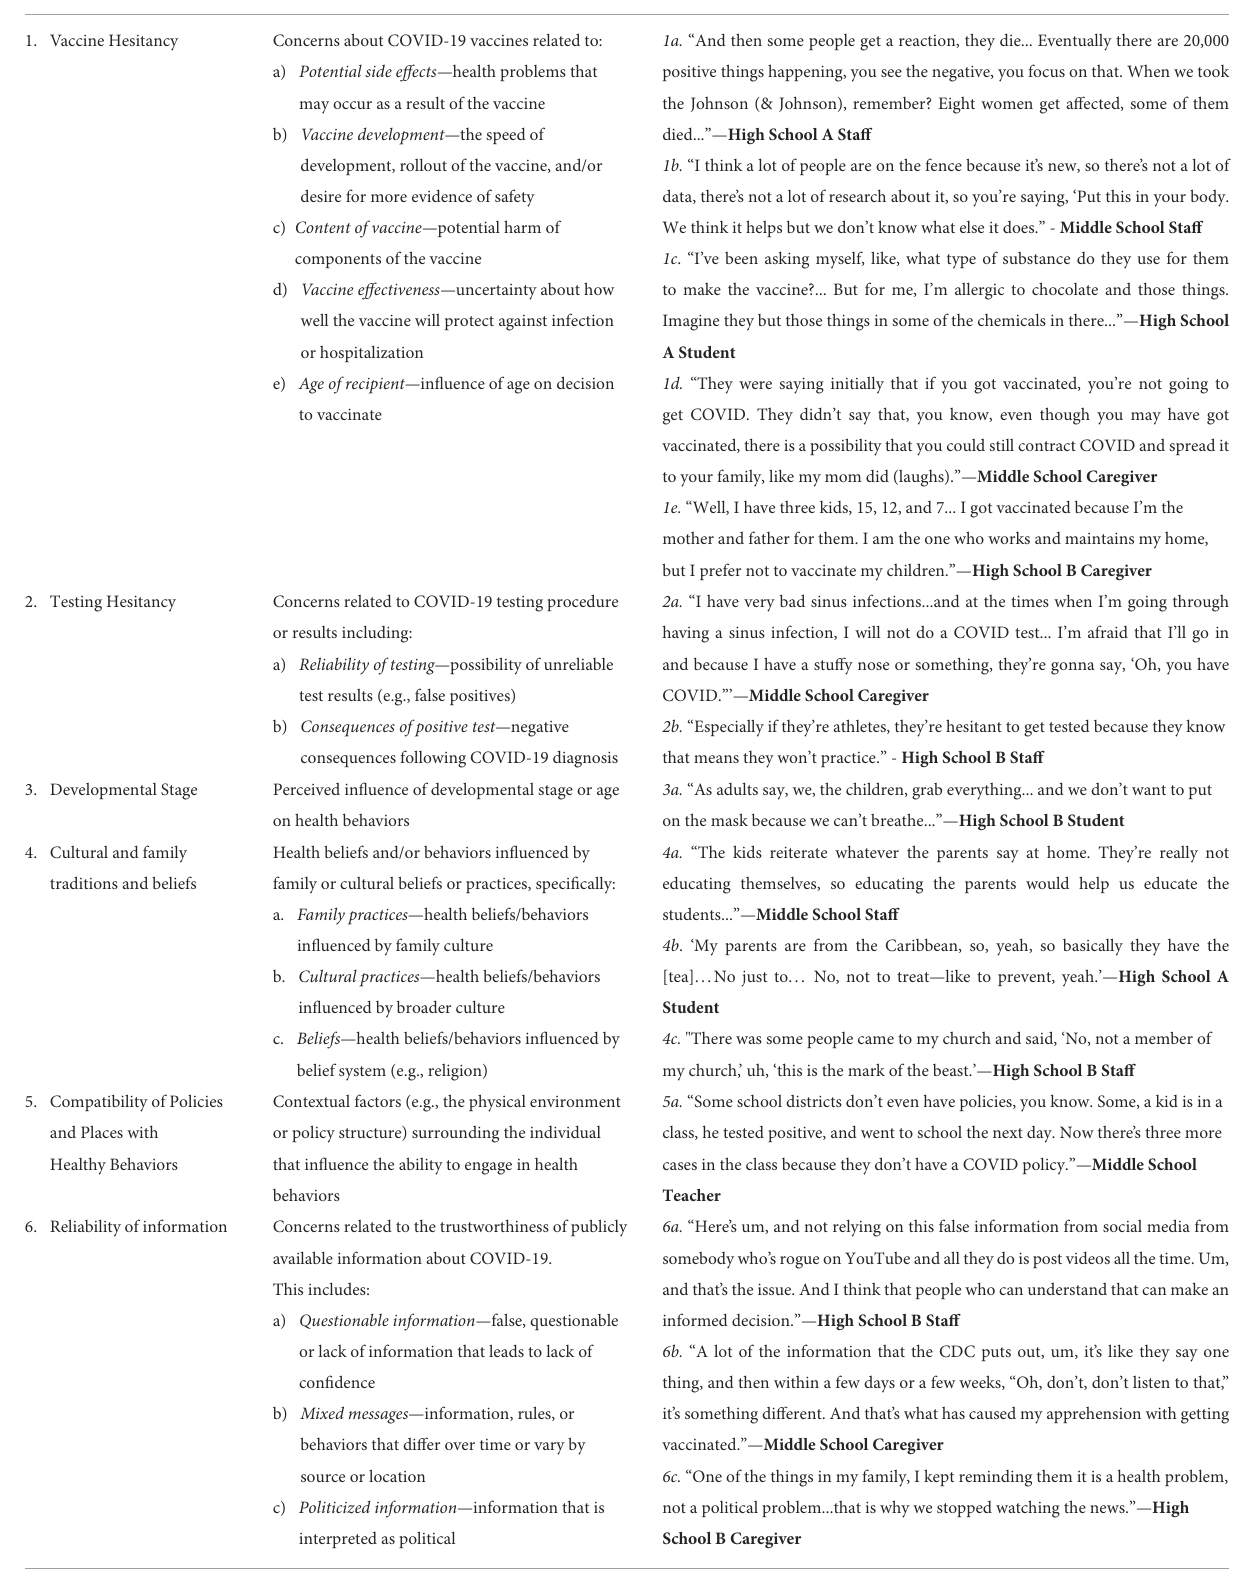
TABLE 2 Factors related to COVID-19 concerns and health